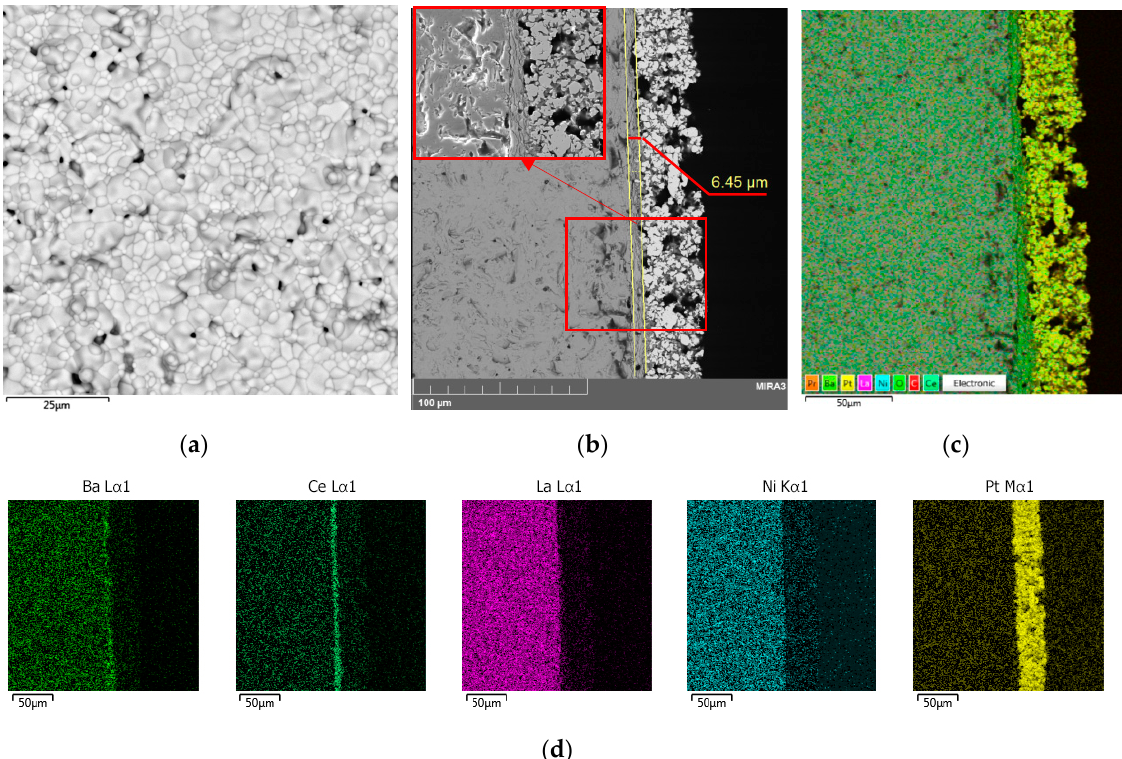
Figure 5. SEM images of the BCGCuO film deposited onto the La 1.7 Ba 0.3 NiO 4 + δ LBNO substrate after the final sintering at 1450 ◦ C, 2 h: ( a ) the film surface; ( b ) the cross-section of the BCGCuO film on the LBNO (on the left) substrate and Pt electrode (on the right); ( c ) integrated EDX mapping image of the cross section; ( d ) individual EDX mapping images of the cross section.